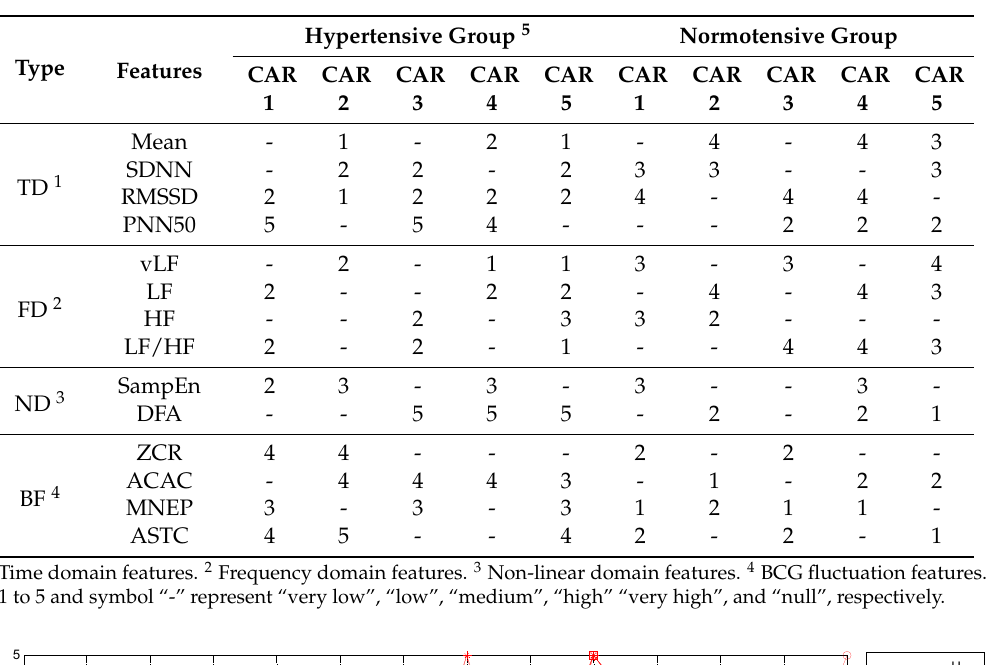
Table 7. The most powerful CARs in hypertensive group and normotensive group.